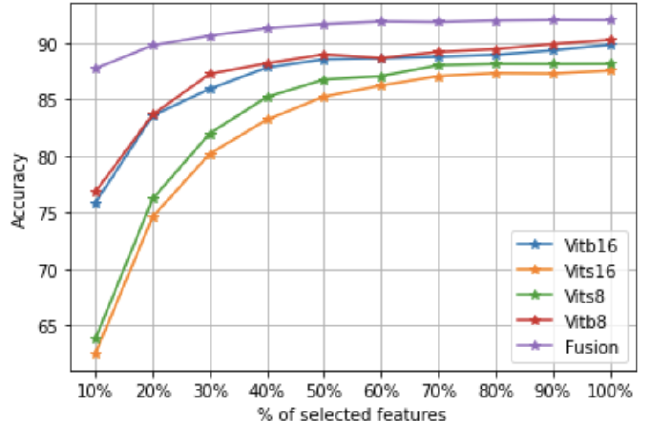
Figure 14. Rate of important feature effects on the classification accuracy of the NWPU-RESISC45 data set with 20 randomly selected images per class.